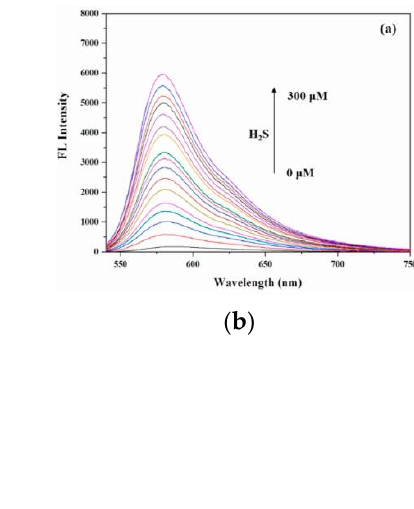
( b ) Figure 30. ( a ) Structure of probe DCP-H 2 S; ( b ) Fluorescence imaging of DCP-H 2 S in normal and tumor-bearing mice. Reproduced with permission from [123]. Copyright 2022 American Chemical Society. 8. Fluorescent Probe for Detecting Hydrogen Peroxide (H 2 O 2 ) Reactive oxygen species (ROS) play an important role in maintaining cellular ho- meostasis and signaling [124 – 126]. Among them, H 2 O 2 is a kind of ROS and a crucial substance for inducing apoptosis [127 – 129]. Studies have found that H 2 O 2 is abnormally